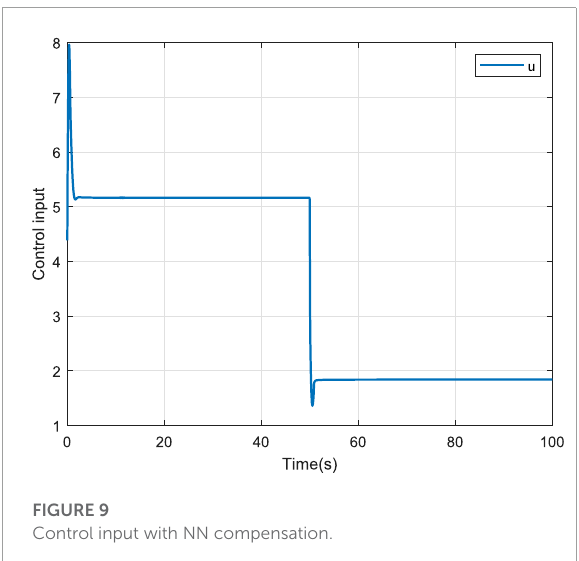
FIGURE 9 Control input with NN compensation.